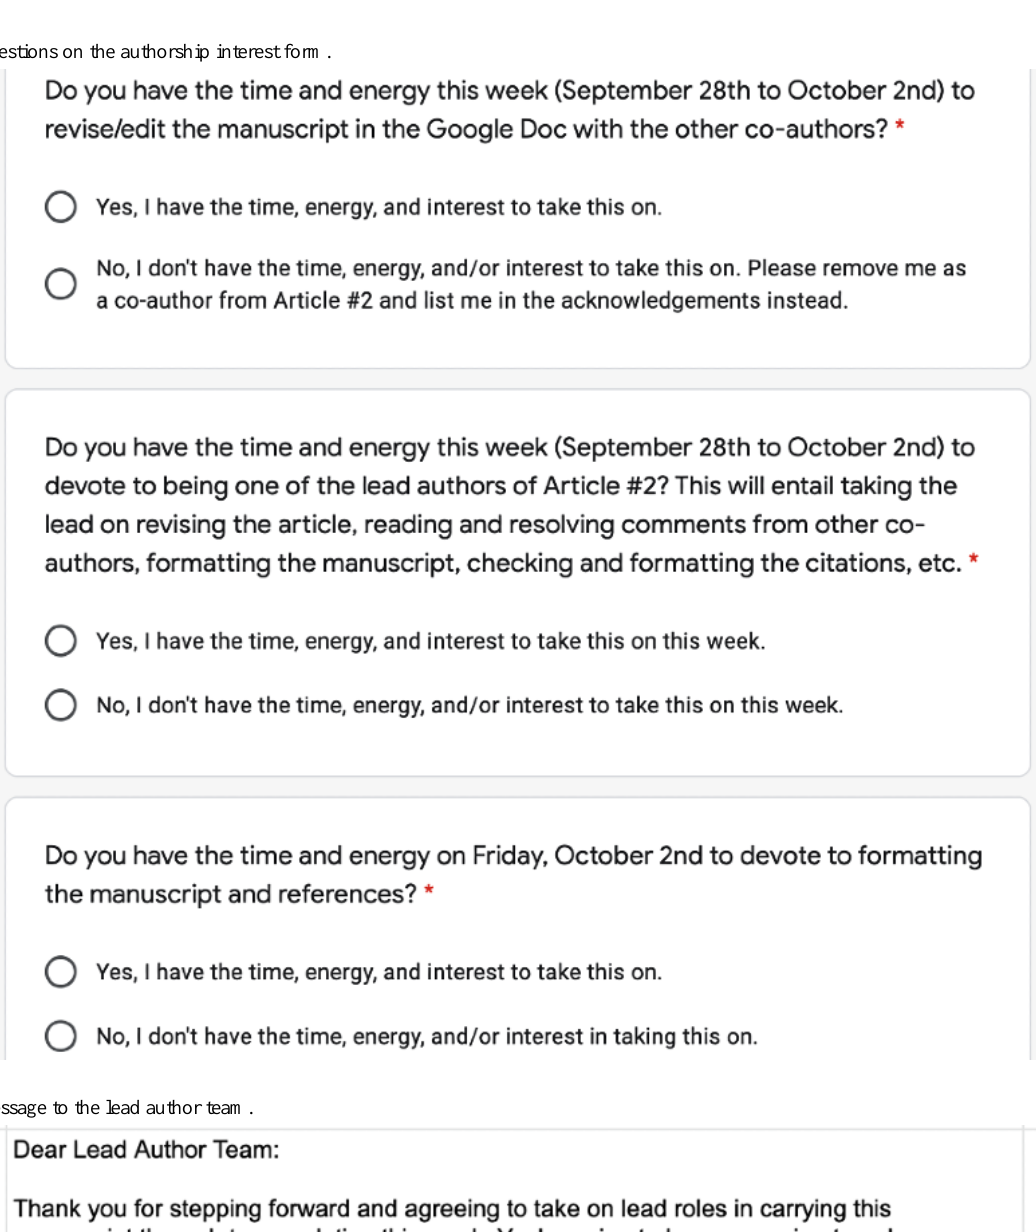
Figure 2. Questions on the authorship interest form.